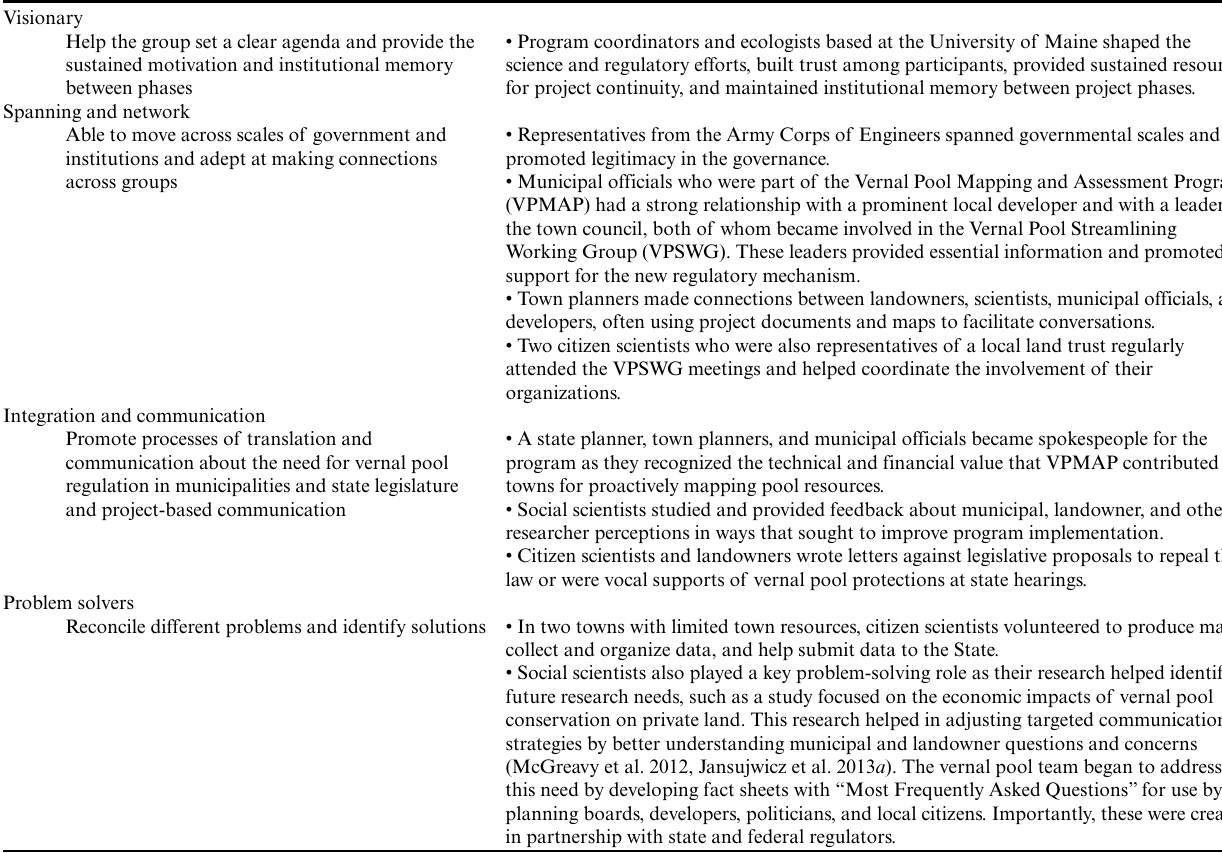
Table 1 . Diverse leadership roles and examples of how knowledge, networks, and leadership promoted the capacity to act within windows of opportunity. Leadership types are adapted from Gunderson et al. (2008), Folke et al. (2002, 2005), and Olsson et al.